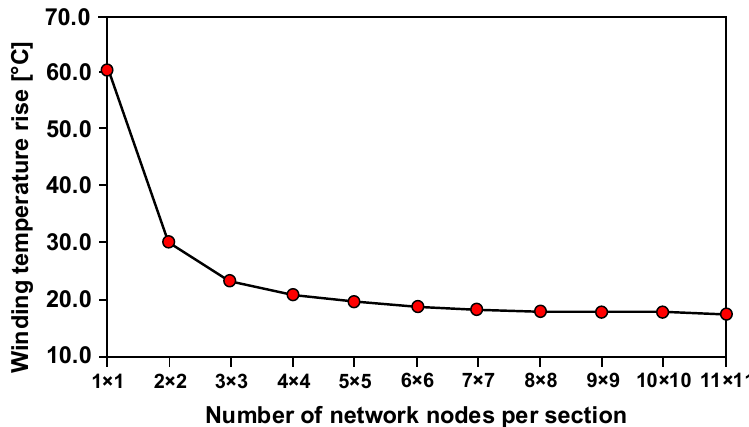
Figure 22. Variation of predicted average temperature rises of winding with increasing discretization level [13].